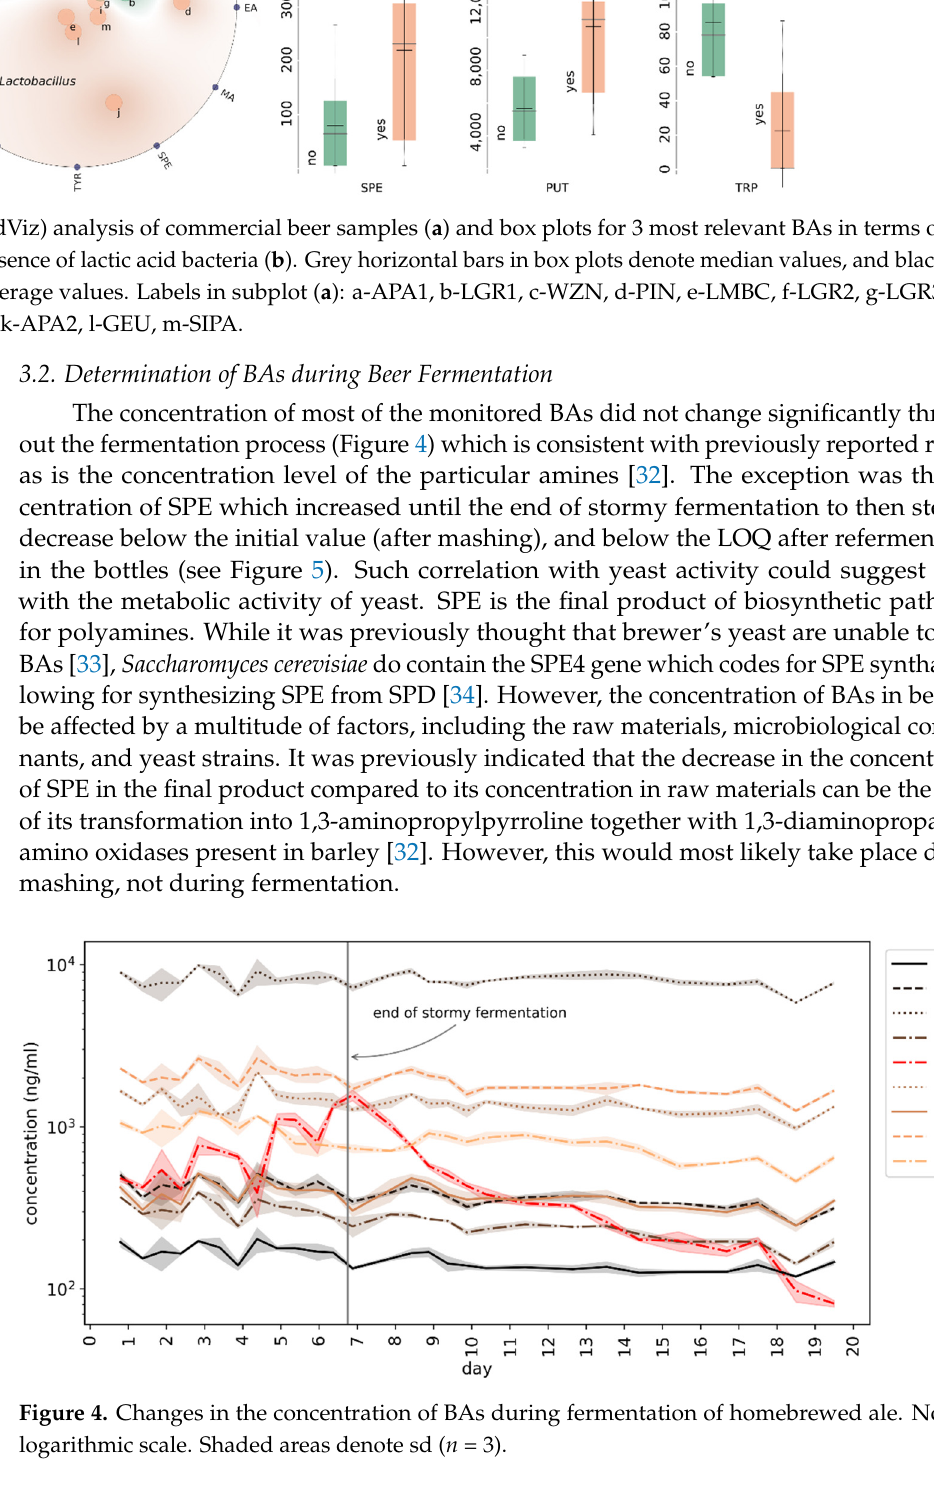
T Figure 5. Change of the concentration of BAs during the production of homebrewed ale relative to the beginning of the fermentation process (0.0) at the beginning of fermentation, during bottling, and after refermentation in the bottles. La ‐ bels above the bars denote concentration in mg/L, and the bars themselves denote sd ( n = 3). 4. Conclusions A method for simultaneous determination of a multitude of BAs in beer was successfully used to analyse several samples of commercially available beers, focusing on the dichotomy of styles which can and ought not to involve lactic fermentation. Multivariate statistical analysis has revealed differences between the two subsets, likely due to the fact that lactic acid bacteria are one of the sources of BAs in alcoholic beverages. In all tested samples, the highest level was noted for PUT and AGM, while in beers brewed with wild yeast (PIN, LMBC, GEU) the content of PUT was significantly higher than AGM. In order to estimate the risk associated with beer consumption, the total content of BAs in the beer samples was calculated. Bearing in mind that the generally safe limit value of the total content of BAs is 100 mg/L (while in alcoholic beverages this threshold is much lower), it was observed that 4 out of 13 beers (sample LGR3, LMBC, GEU, APA2) in which the total BA content exceeded 60 mg/L may pose a risk even to a